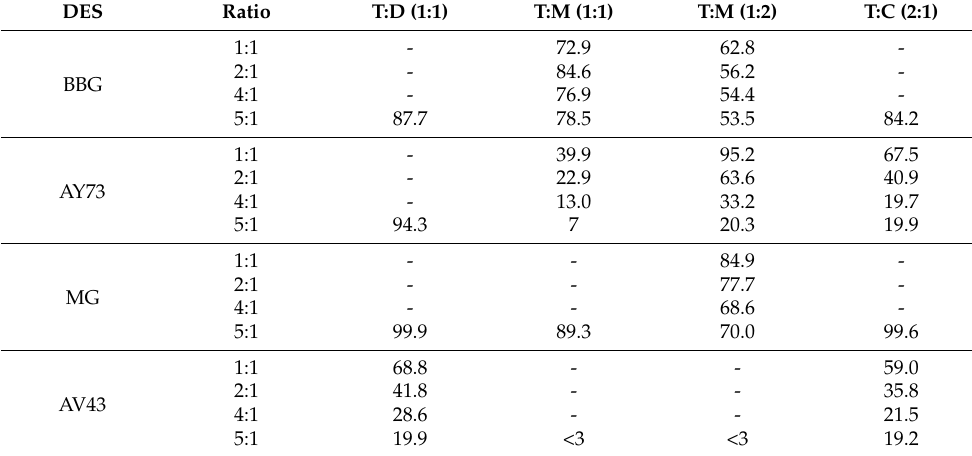
Table 1. Influence of aqueous:organic phase in EE.